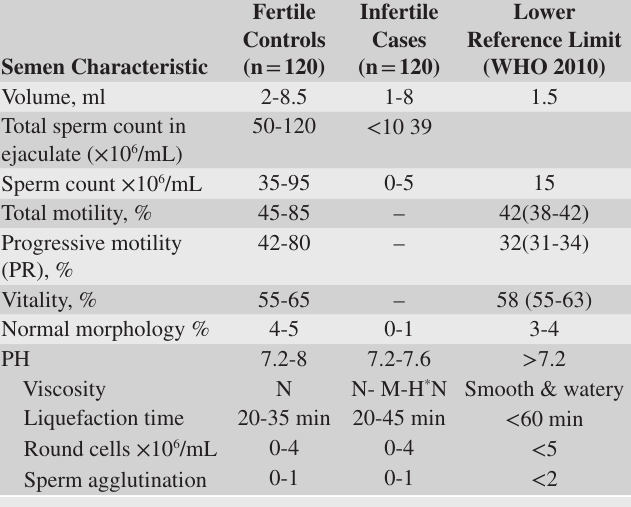
Table 2. Semen Characteristic